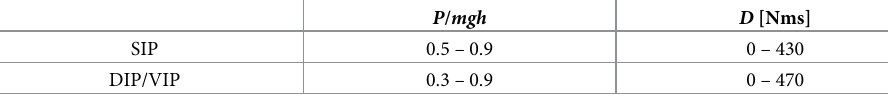
Table 3. Range of stability of the intermittent